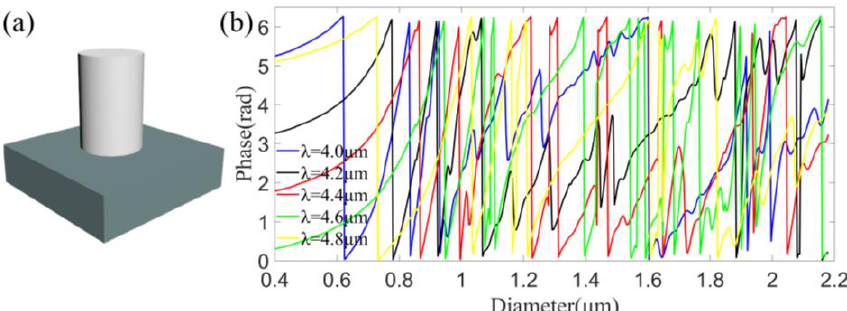
Figure 2. ( a ) Schematic of the unit cell, composed of a silicon nanopillar on fused silica substrate. ( b ) Simulated phase shifts (folded between 0 and 2π) as functions of the nanopillar diameters at wavelengths of 4.0 μm (blue), 4.2 μm (black), 4.4 μm (red), 4.6 μm (green) and 4.8 μm (yellow), i.e., the database.